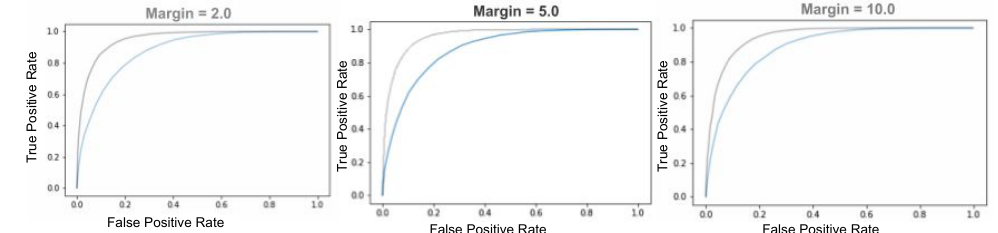
Figure 6. ROC curves for 128 × 128 (blue) and 224 × 224 (gray) learned descriptors for different margin